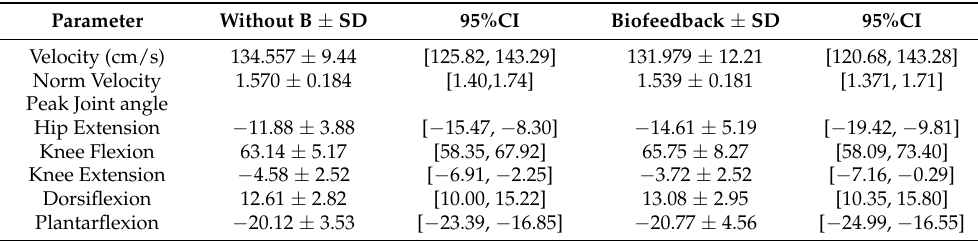
Table 2. Secondary outcome variables of the gait comparing with and without the presence of biofeedback.